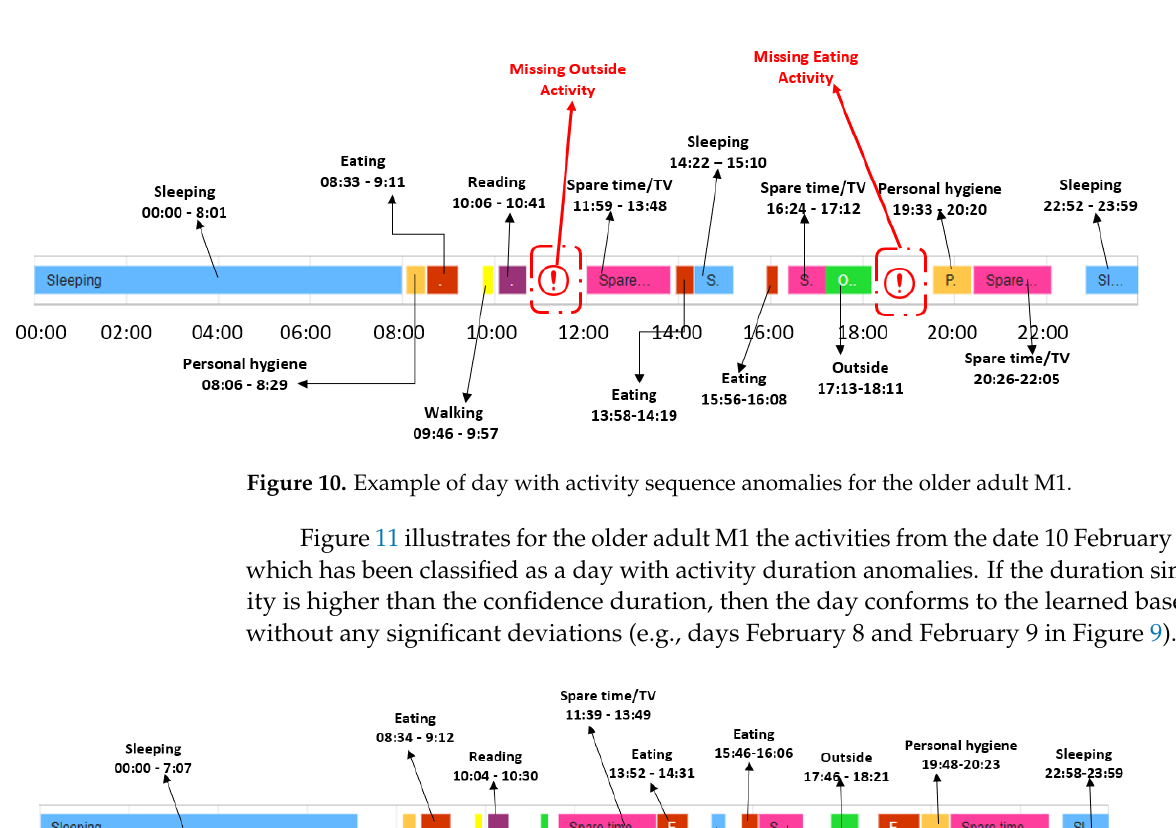
Figure 9. Deviation detection process on the testing data set for older adult M1.